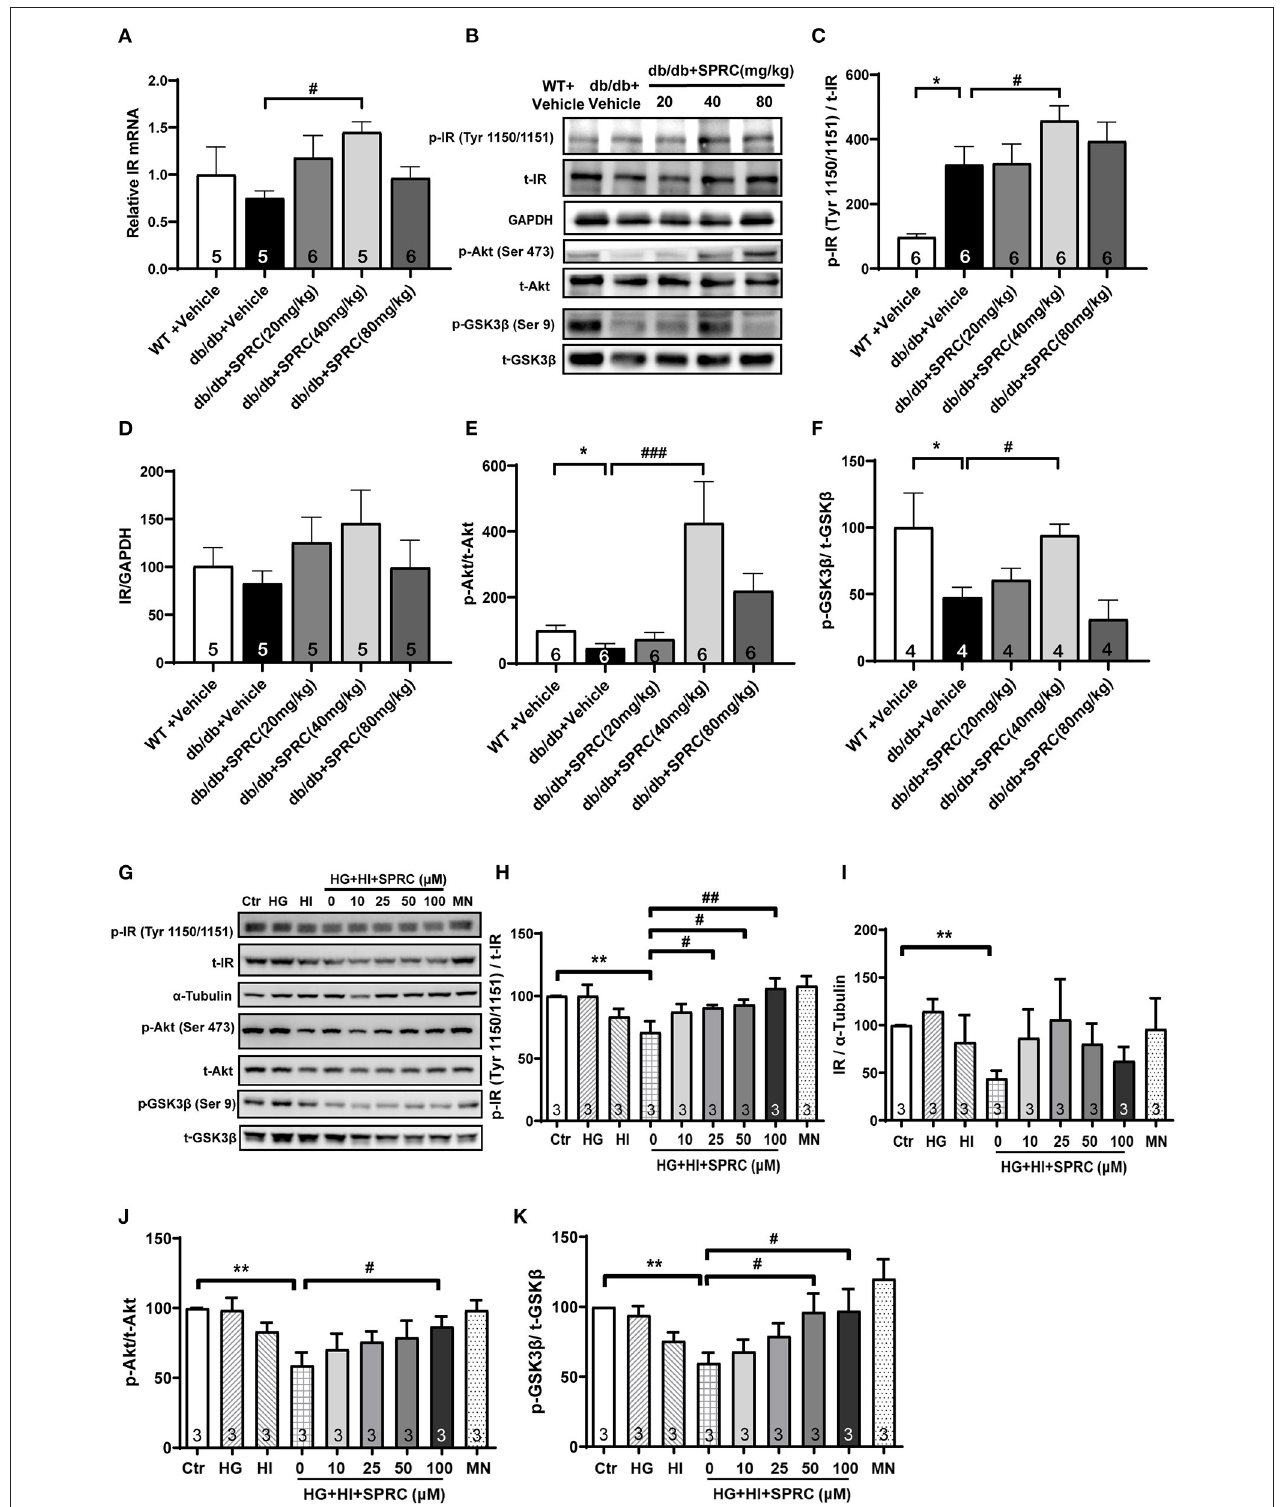
FIGURE 7 | SPRC treatment activated insulin receptor signaling in db/db mice. Vehicle or SPRC (20, 40, or 80 mg/kg/day) was orally administered to WTmiceor db/db micefor12weeks. (A) ThemRNAlevelsofinsulinreceptor( Insr )weredeterminedbyreal-timeqPCR.mRNAlevelsof Gapdh